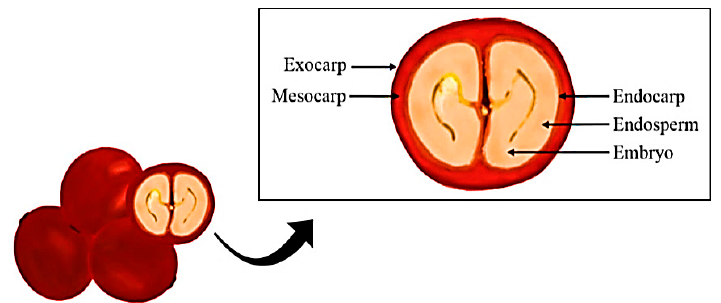
Figure 1. Morphology of the co ff ee fruit (authorial).